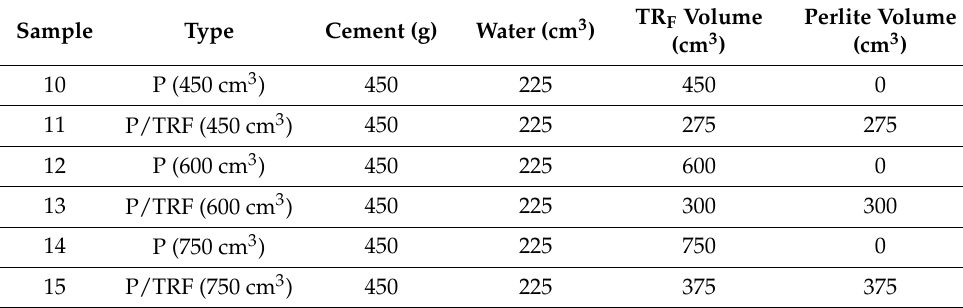
Table 4. Expanded perlite and tire rubber mortars